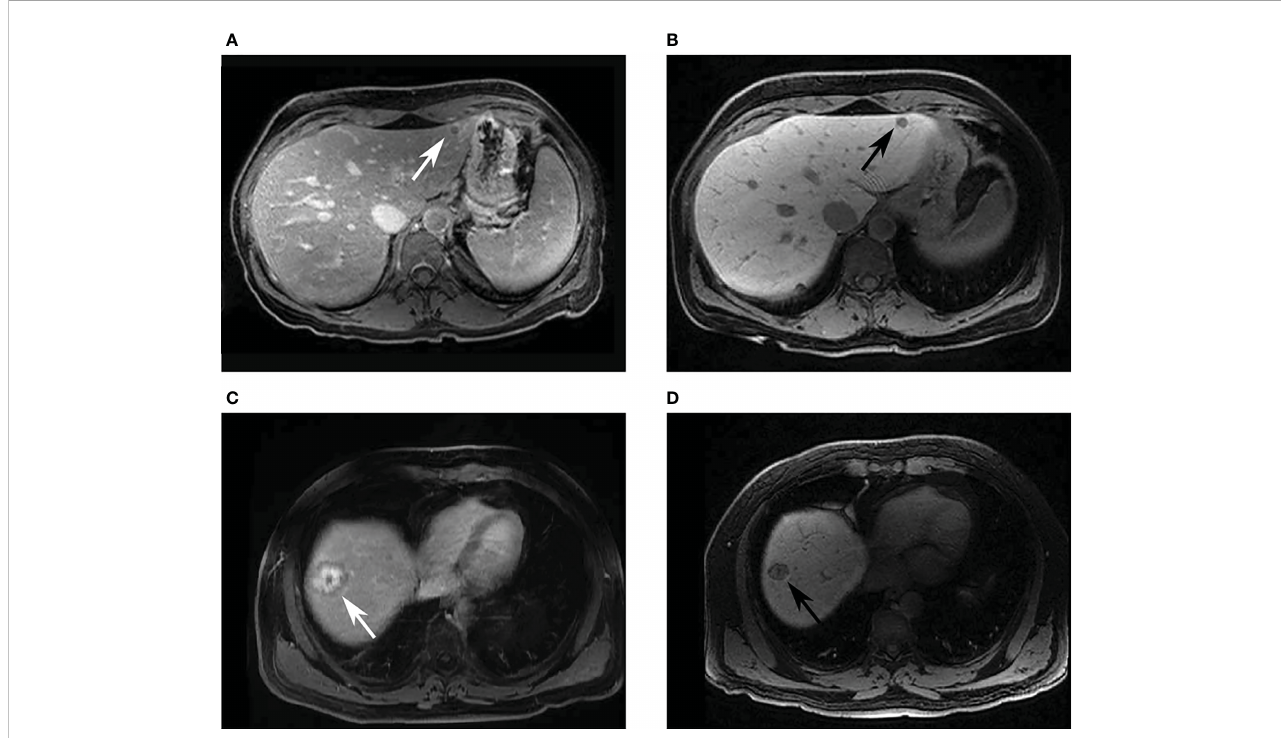
FIGURE 3 Example images of patients who had received both Gd-DO3A-butrol and Gd-EOB-DTPA-enhanced imaging. Two patients with colorectal cancer liver metastases. A 44-year-old female patient with a hypointense lesion in both (A) 10-minute delayed Gd-DO3A-butrol-enhanced T1 axial image, and (B) 20-minute delayed Gd-EOB-DTPA-enhanced T1 axial image. A 58-year-old male patient with 3-layer tumor enhancement pattern in both (C) 10-minute delayed Gd-DO3A-butrol-enhanced T1 axial image and (D) 20-minute delayed Gd-EOB-DTPA-enhanced T1 axial image taken after 3 months. The patient received chemotherapy during the interval. MA: minor axis length, DA: gray level dependence